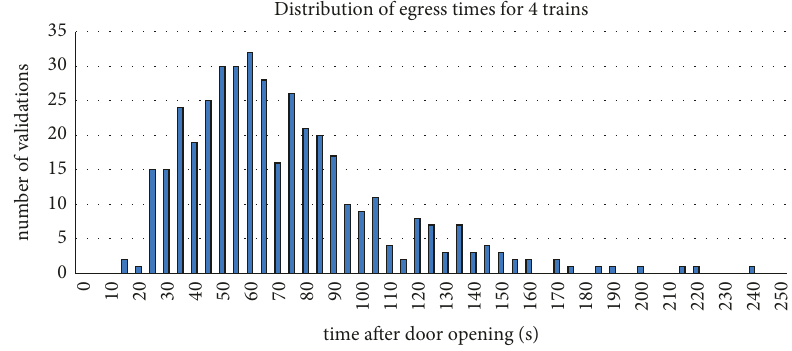
Figure 4: Distribution of observed egress times.